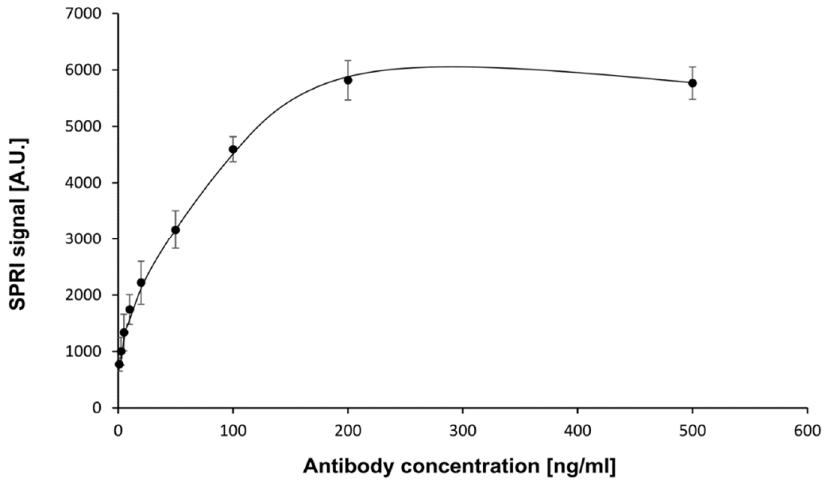
Figure 2. Dependence of SPRI signal (Arbitrary Units) on mouse NRP-1 antibody concentration. NRP-1 concentration: 5 ng/mL. pH = 7.4. Error bars were calculated for 12 independent measure- ments for each concentration at a 95%confidence level.